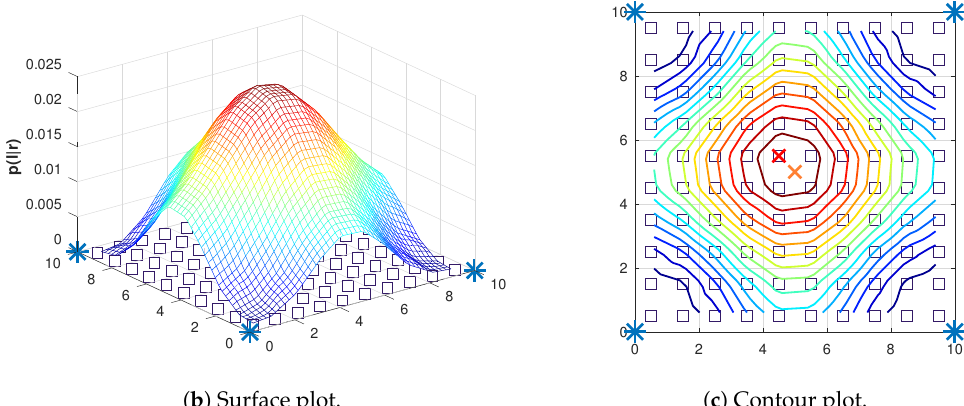
( b ) Surface plot. ( c ) Contour plot. Figure 3. Simulated scenario with 4 APs, 100 RPs and 1 test